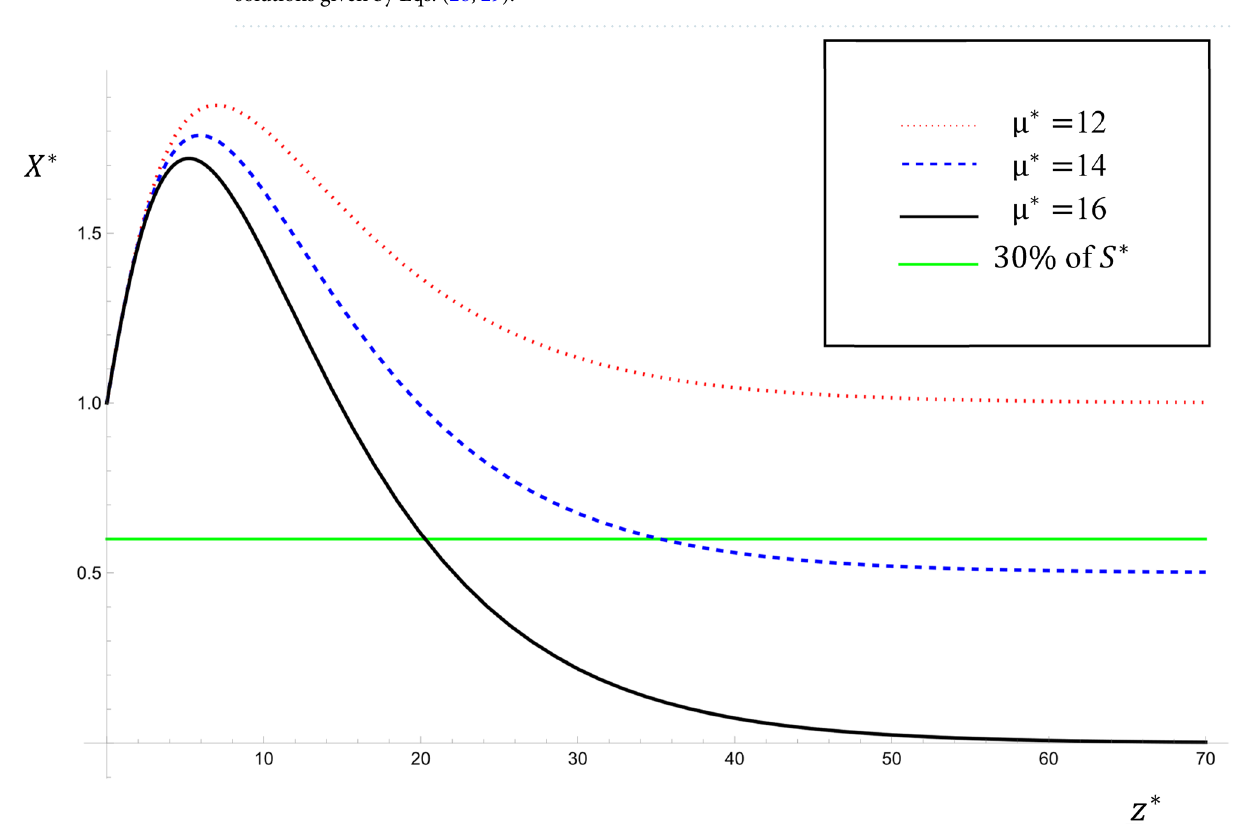
0.01, 0.1, 1 for the steady state analytical =